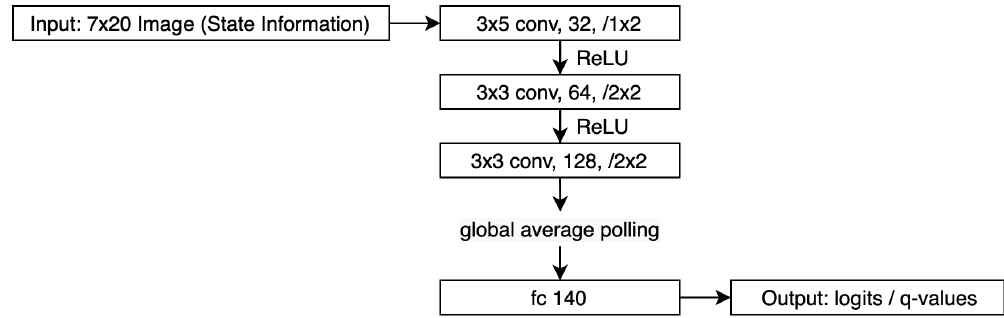
Figure 5. Policy and Q-function neural network